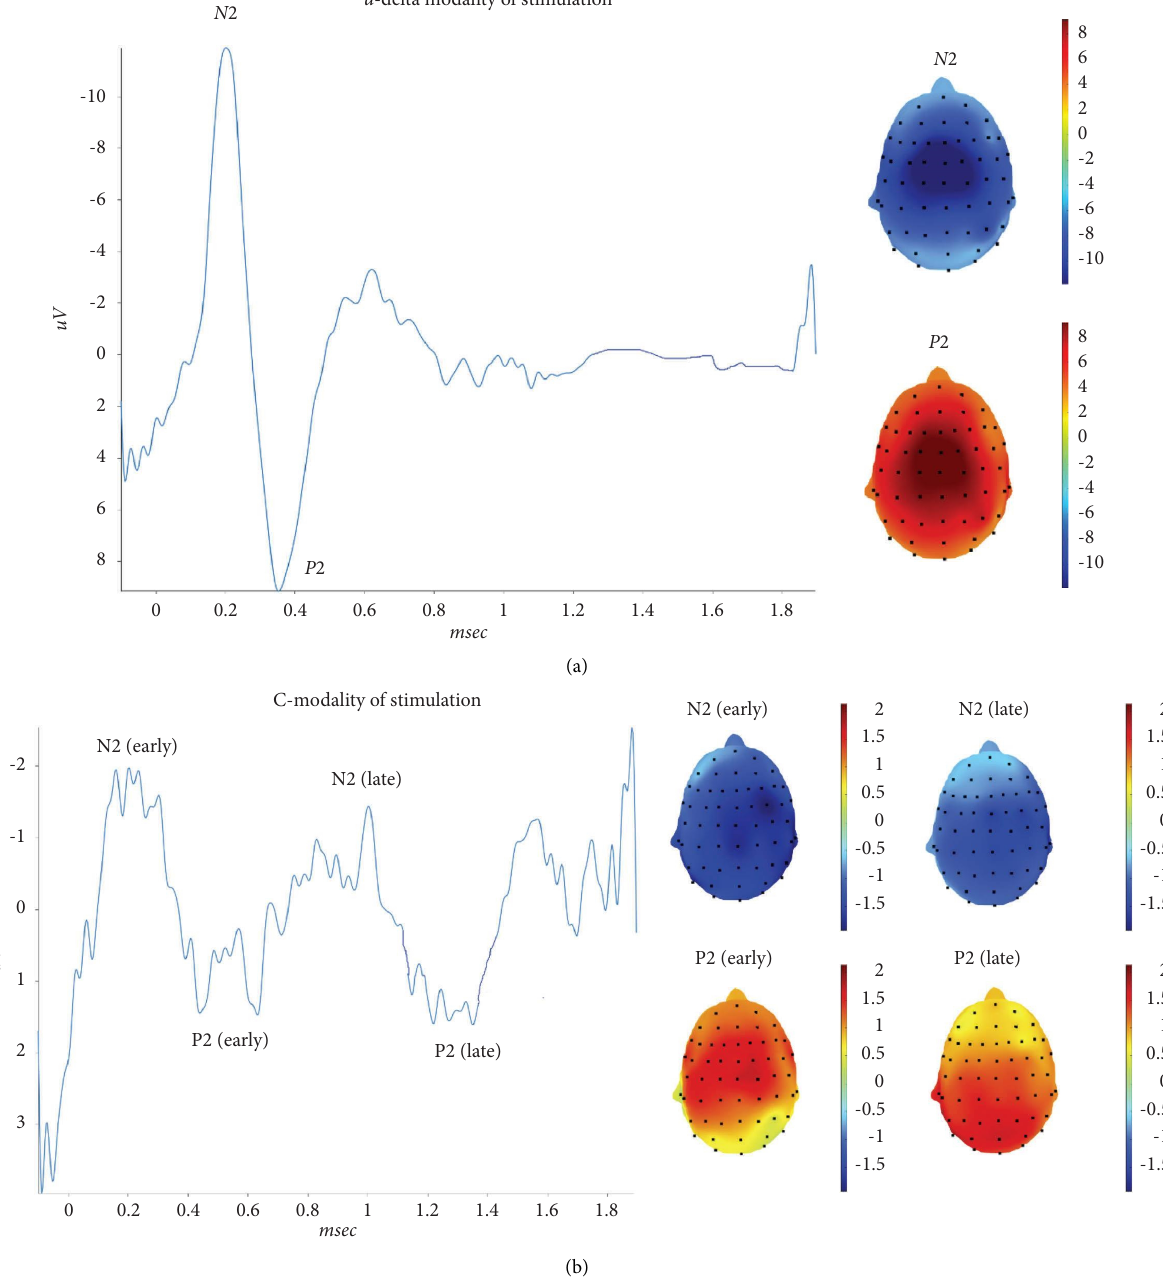
Figure 4: On the left side, the grand average of N2 P2 waves was obtained by right knee stimulation. On the right side, the corresponding topographical maps are represented. Te grand average in the lower part of the fgure, for the C-modality of stimulation, shows to distinct negative/positive (early and late) complexes. Te topographical maps refers to the recorded N2-P2 waves. Upper: a-delta modality of stimulation. Lower: C-modality of